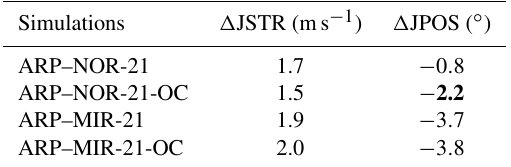
Table 5. Changes in mean yearly southern westerly wind maximum strength ( (cid:49) JSTR, ms − 1 ) and position ( (cid:49) JPOS, ◦ ) for the different ARPEGE projections. Changes significantly different using bias- corrected SSCs are shown in